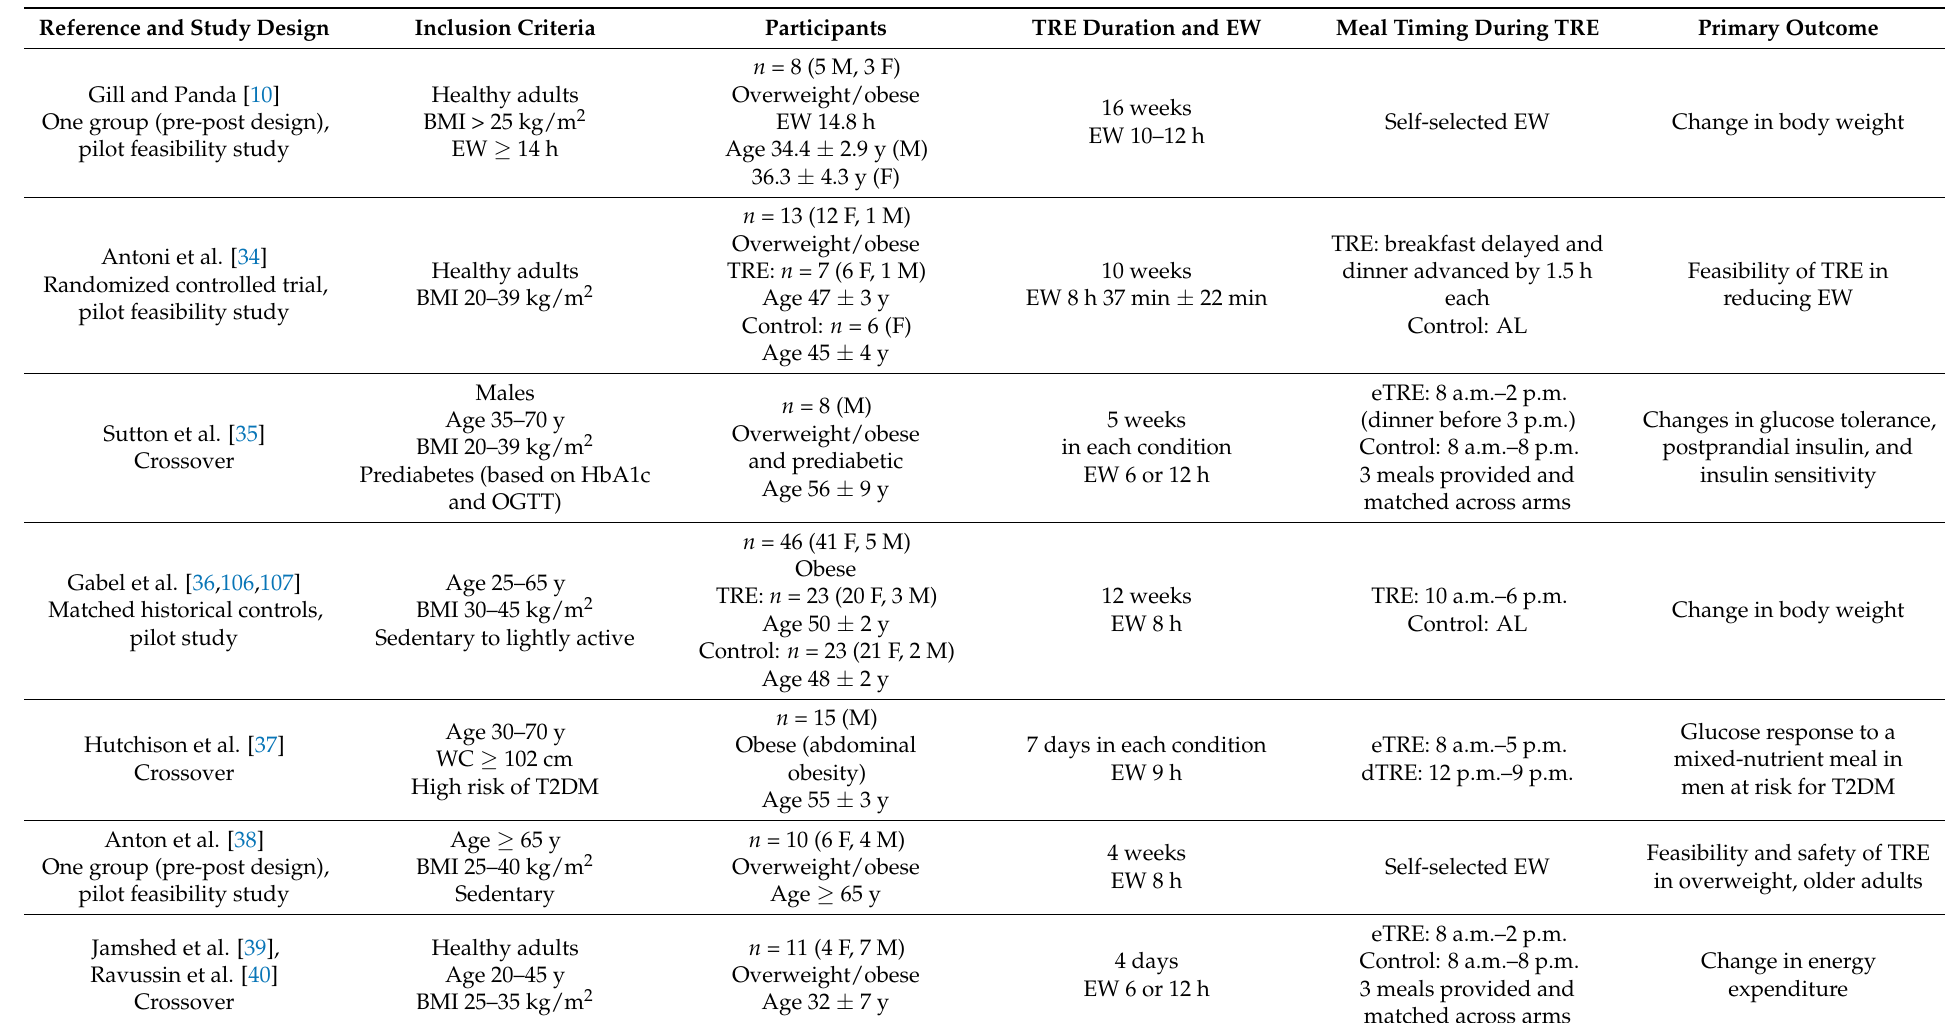
Table 1. Main characteristics of time-restricted eating trials in humans with metabolic syndrome or its